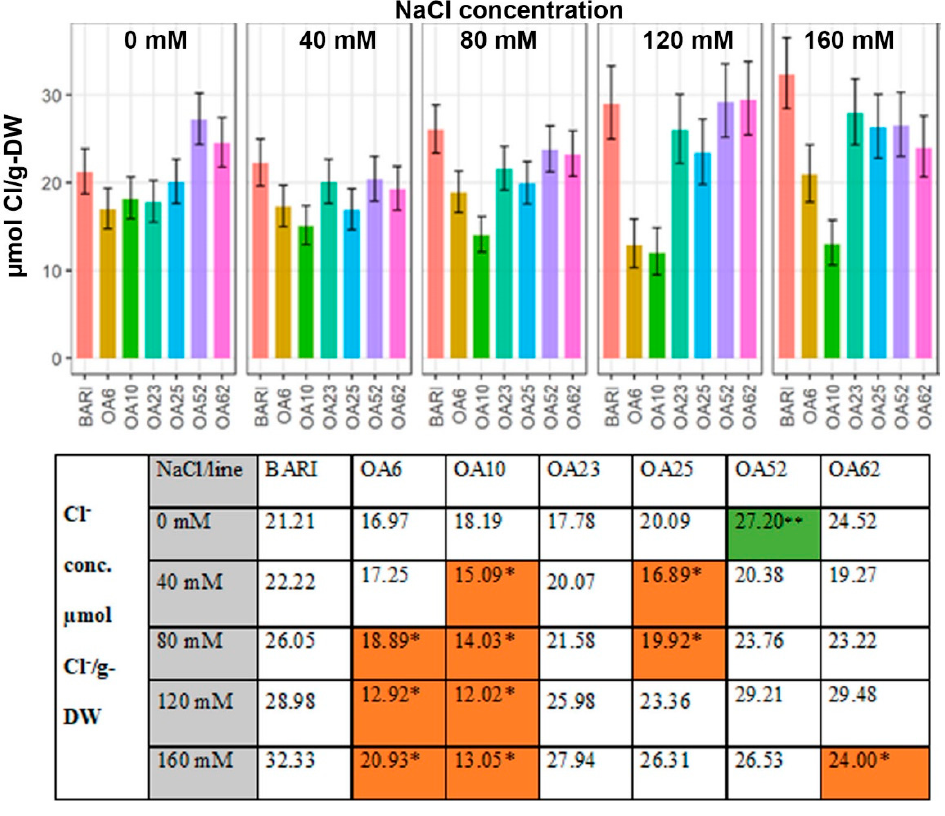
Figure 4. Dry weight (DW) concentration of Cl - at DAP 39–40. Data are shown for the control BARI Gom-25 (BARI) and mutagenized wheat lines OA6, OA10, OA23, OA25, OA52, and OA62 at DAP 39–40. NaCl concentrations applied were in the range from 0 mM to 160 mM. Upper panel: Cl - values with half-LSD error bars. Lower panel: table high-lighting the Cl - mean values with color codes for significantly higher (dark green **) or lower (orange *) values compared to BARI Gom-25, p ≤ 0.05.